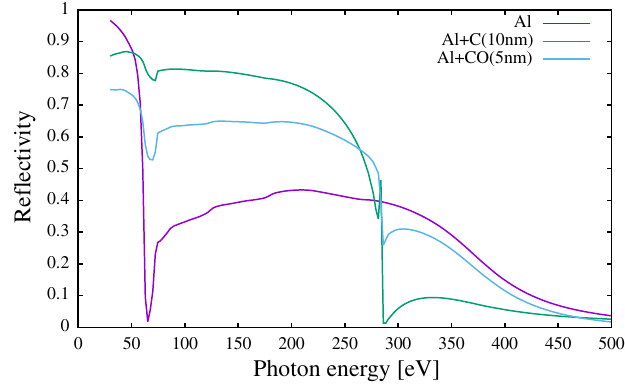
FIG. 8. Smooth-surface photon reflectivity versus photon en- ergy for aluminum, aluminum with a 10-nm carbon layer, and aluminum with a 5-nm carbon monoxide layer, for photons incident at a 5° grazing angle.